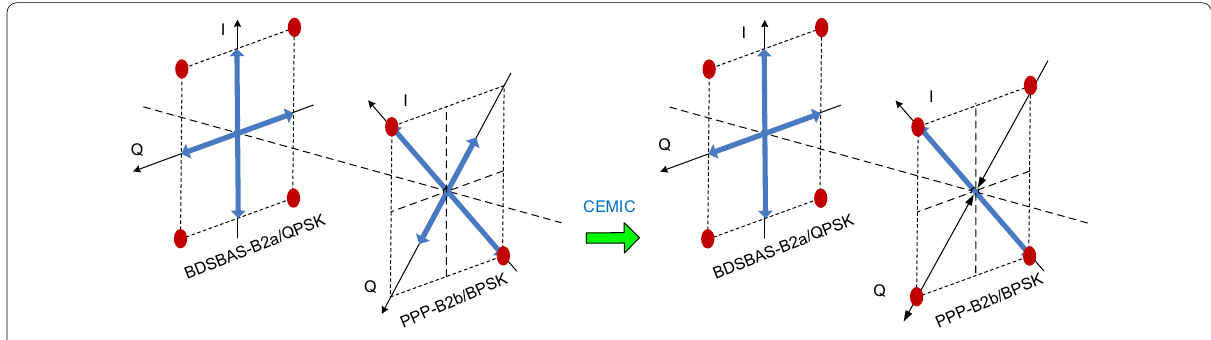
Fig. 7 Intermodulation component suppression of PPP-B2b